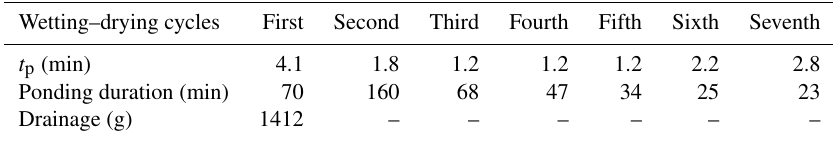
Table 2. Manual readings of external hydrological responses.